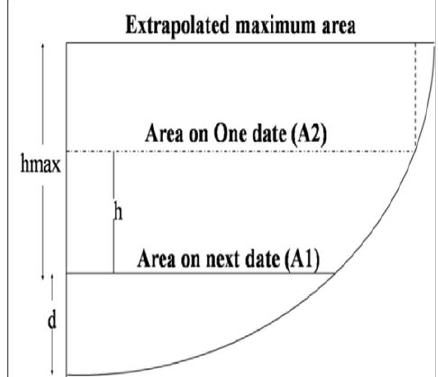
Fig. 2. Modified Trapezoidal Method Line diagram (source: